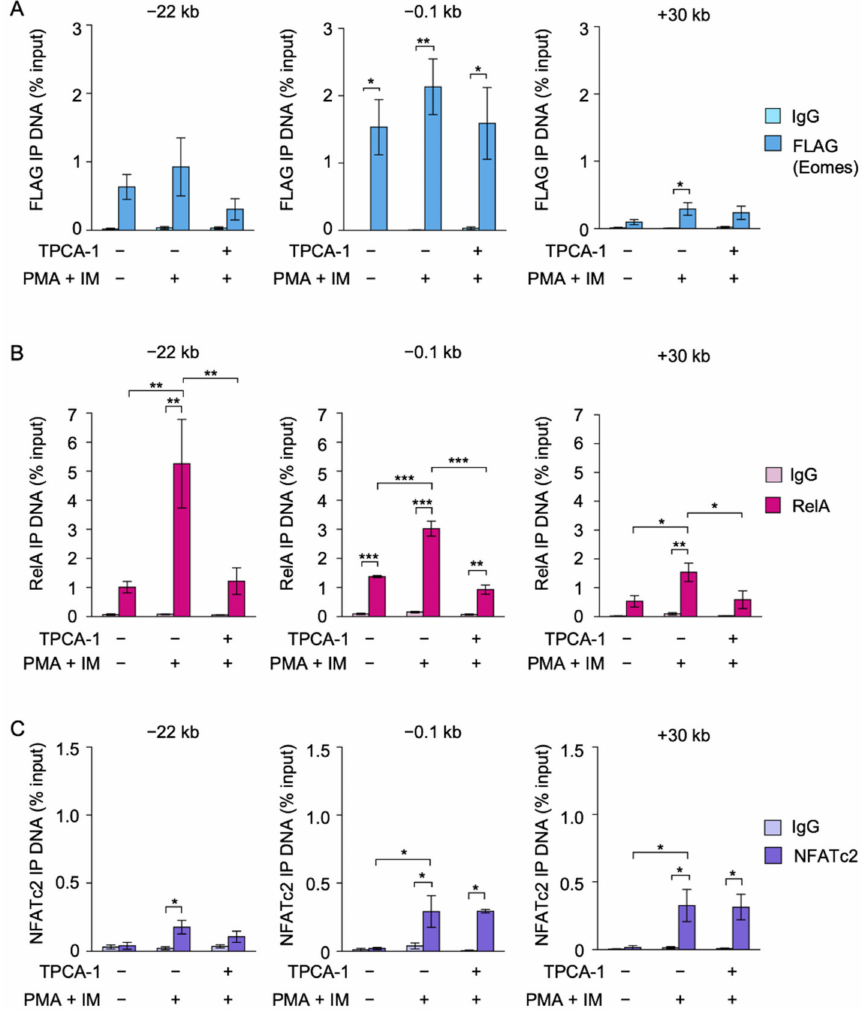
Figure 5. Effects of TPCA-1 on the binding of RelA, FLAG-Eomes, and NFATc2 to the IFN- γ promoter, CNS − 22, and CNS+30 in EL4 transfectants. ( A – C ) Eomes #2 EL4 transfectants were pretreated with (+) or without ( − ) TPCA-1 for 1 h and then treated with (+) or without ( − ) PMA (10 nM) and IM (1 µ M) for 2 h in the presence or absence of TPCA-1 (20 µ M). ChIP assays were performed for FLAG-Eomes ( A ), RelA ( B ), and NFATc2 ( C ) using control IgG (light color bars) or specific antibodies (dark color bars). Quantitative PCR was used to measure the amounts of DNA regions. Immunoprecipitated (IP) DNA (% input) is shown as the mean ± S.E. of four ( A ) and three ( B , C ) independent experiments. * p < 0.05, ** p < 0.01, and *** p <